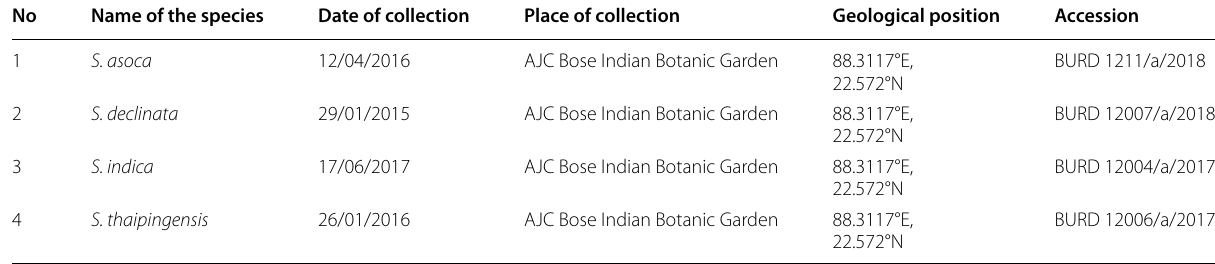
Table 1 Details of plant material applied for experiment No Name of the